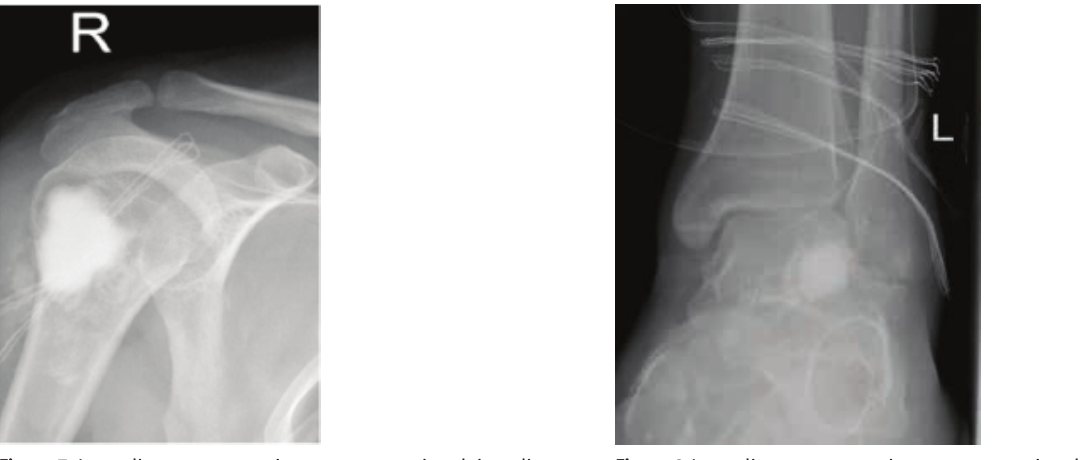
Figure 7: Immediate post-operative antero-posterior plain radio- graph demonstrating filling the void with CERAMENT after curettage of the enchondroma of the humerus.